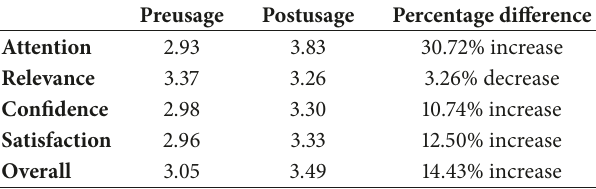
Table 1: Mean values for ARCS